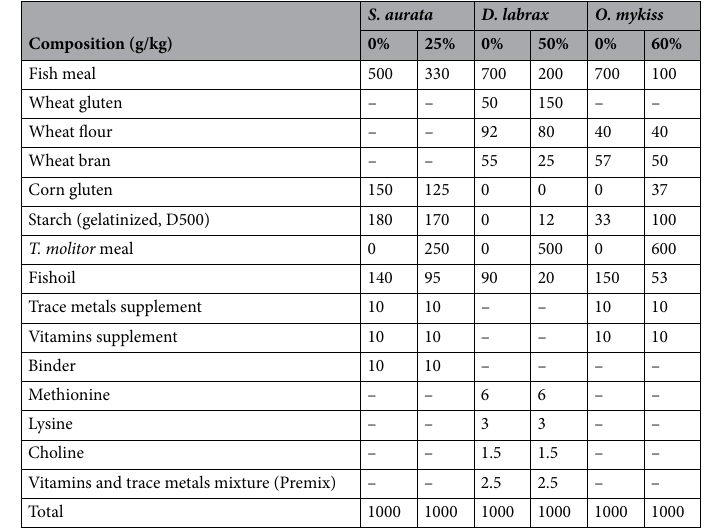
Table 1. Composition of the experimental diets. Gasco et al. 9 and Piccolo et al. 11